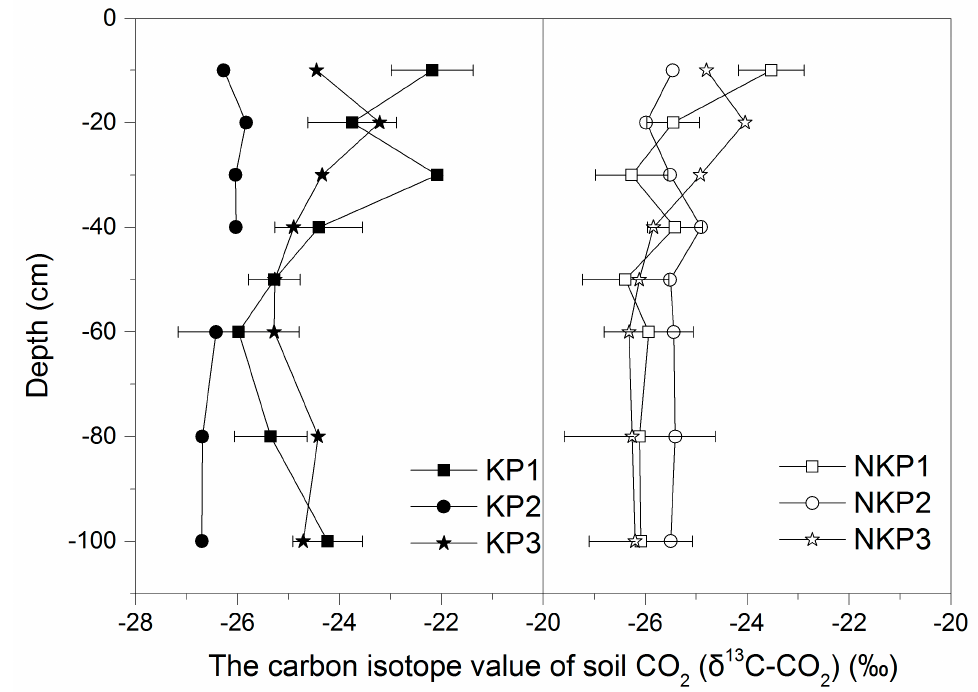
Figure 6. δ 13 C-CO 2 values in different depth layers of the calcareous and red soils.